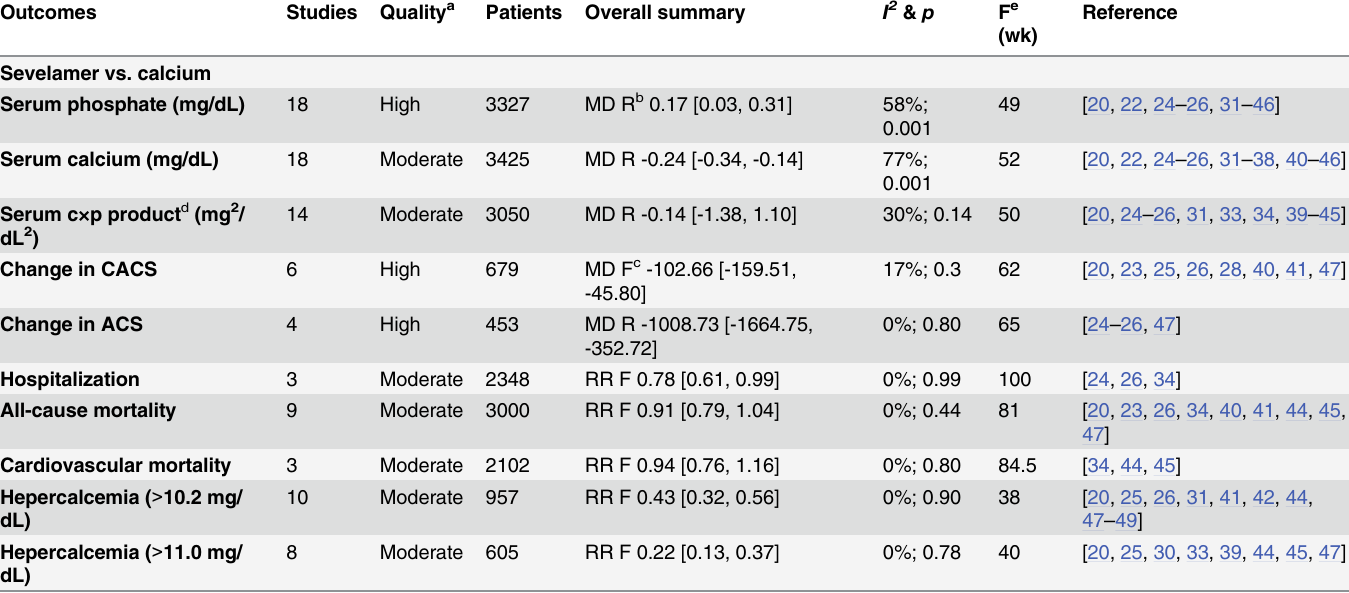
Table 4. Overall outcome